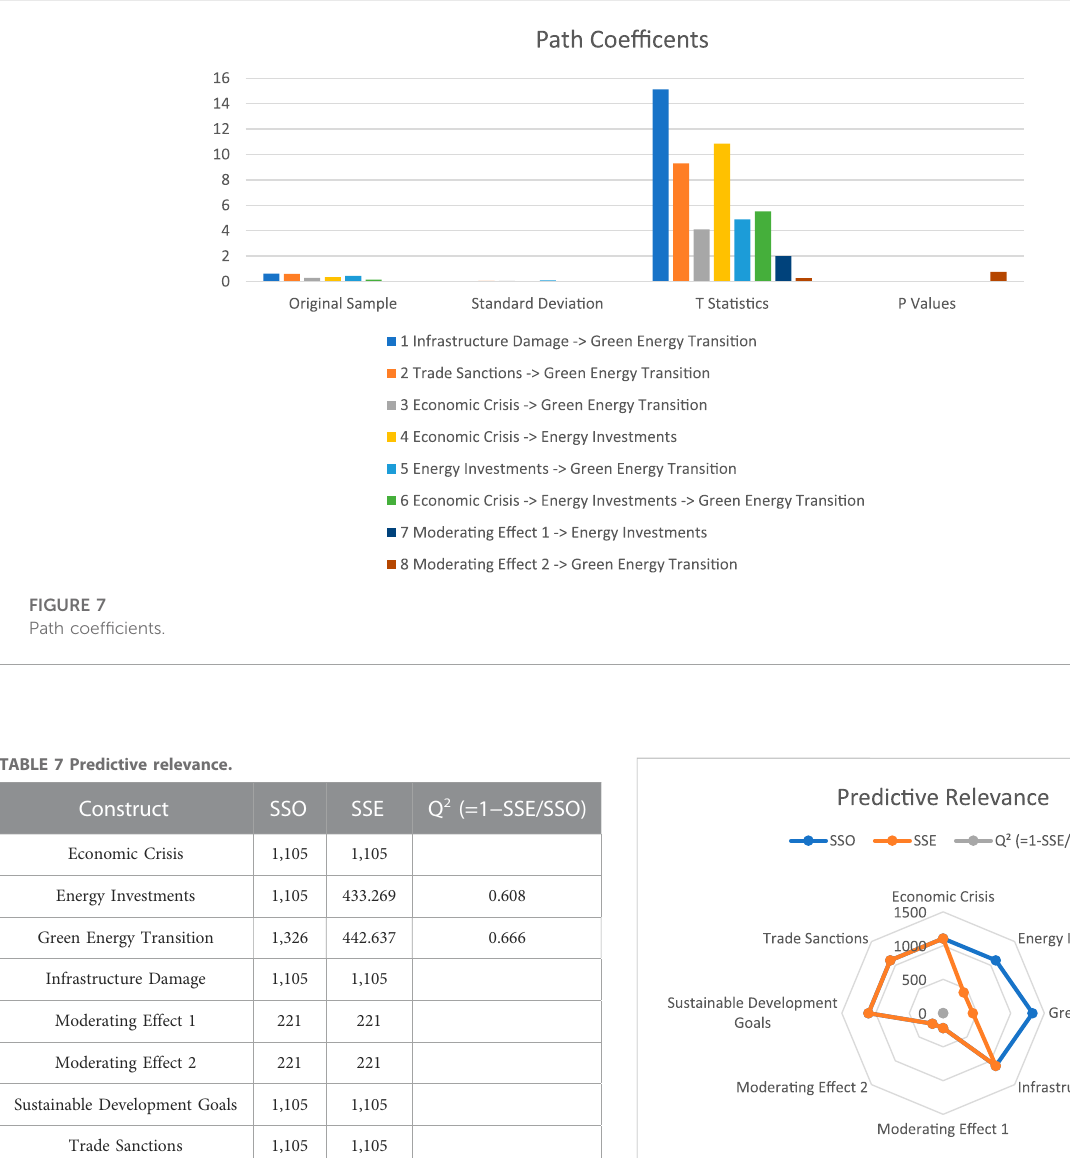
FIGURE 8 Predictive